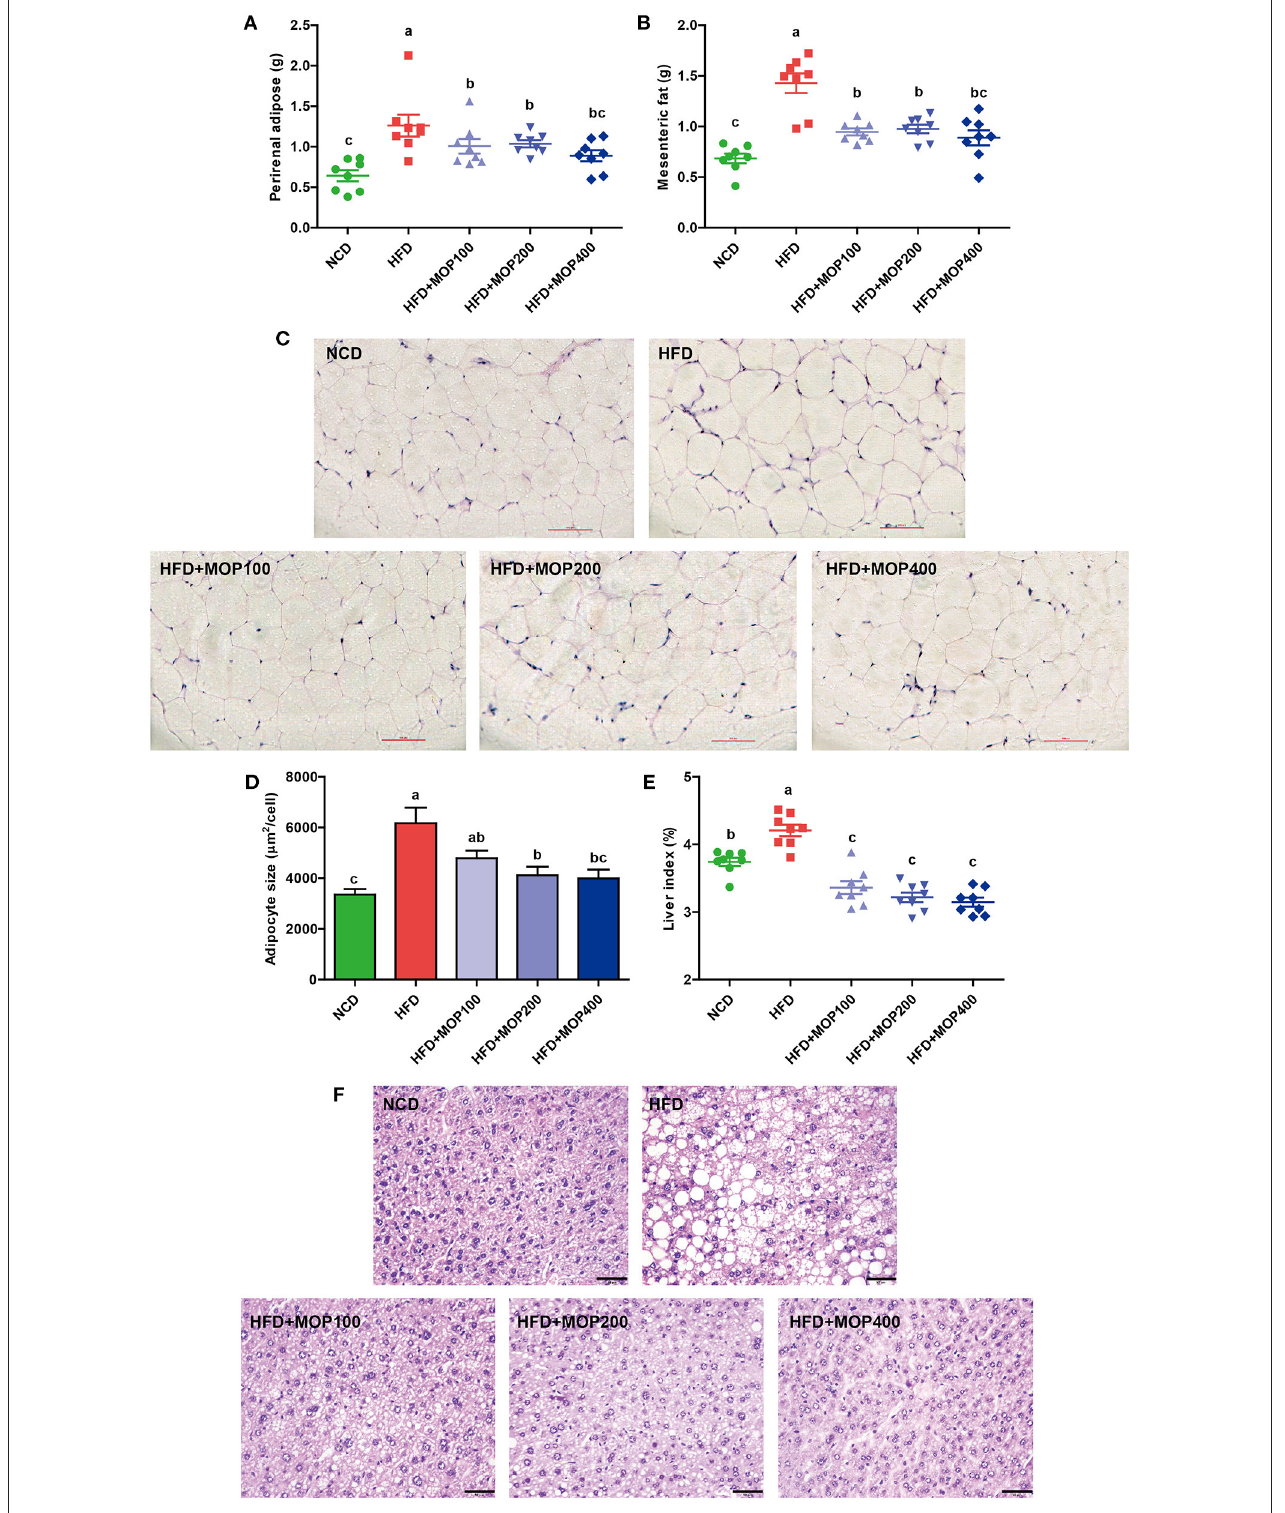
FIGURE 2 | Preventive effects of MOP on fat accumulation in HFD-fed mice ( n = 8 mice/group). (A) Perirenal fat weight, (B) Mesenteric fat weight, (C) Histological examination of perirenal fat by H & E staining, scale bar = 100 µ m, (D) Adipocyte size was monitored in mesenteric fat tissue, (E) Liver index, (F) Representative liver histology by H & E staining, scale bar = 50 µ m. Data are shown as means ± SEM. Bars marked with different superscript letters (a–c) indicate significant differences at p < 0.05 based on one-way ANOVA with Duncan’s post-hoc test.